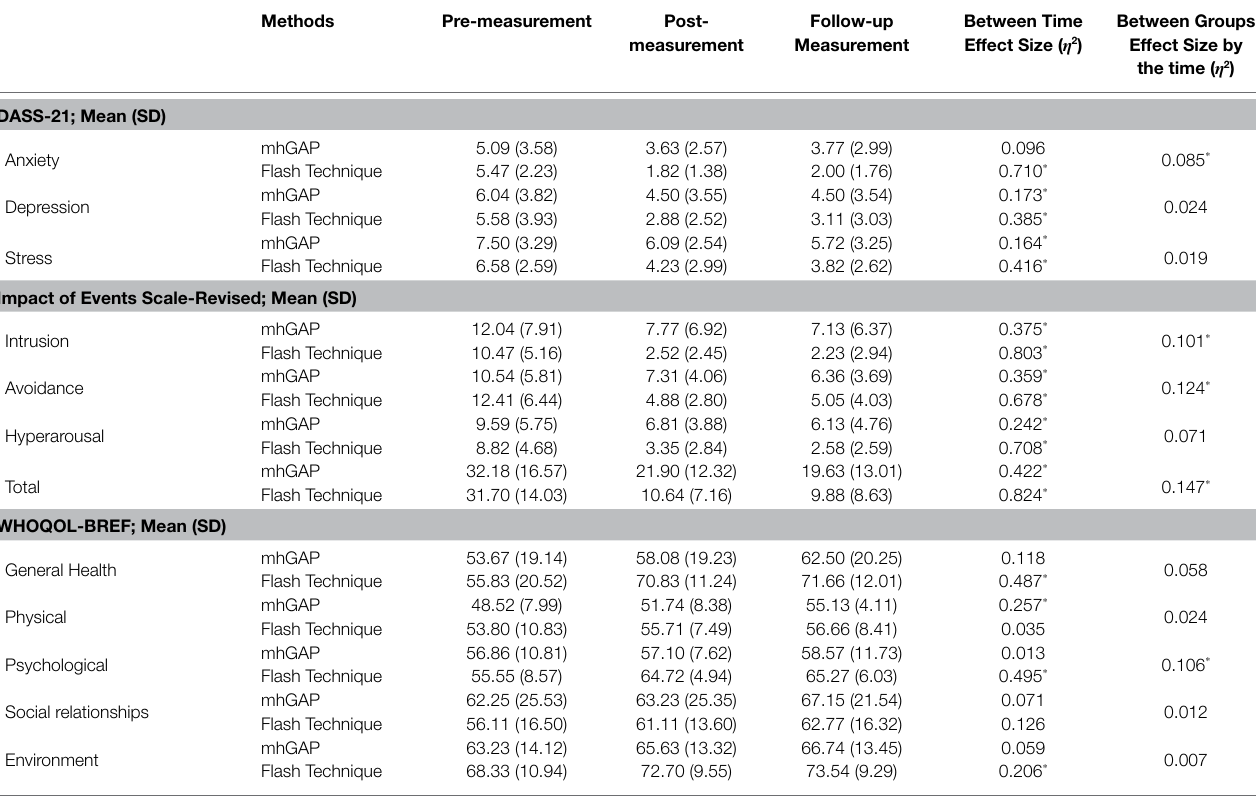
TABLE 2 | Descriptive statistics for outcome variables in the mhGAP and flash technique.